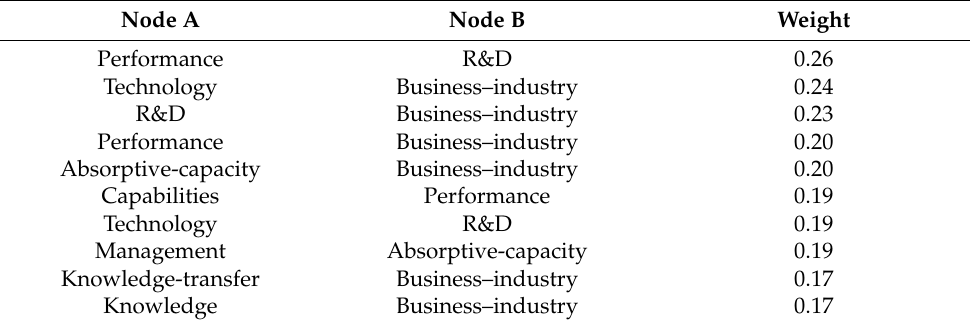
Figure 6. Evolution of the themes period 2013–2016 and thematic network of the cluster BUSINESS–INDUSTRY. Source: Prepared by the authors on the basis of SciMAT data. Table 6. Thematic network business–industry, 2013–2016. Ten relationships with more weight.